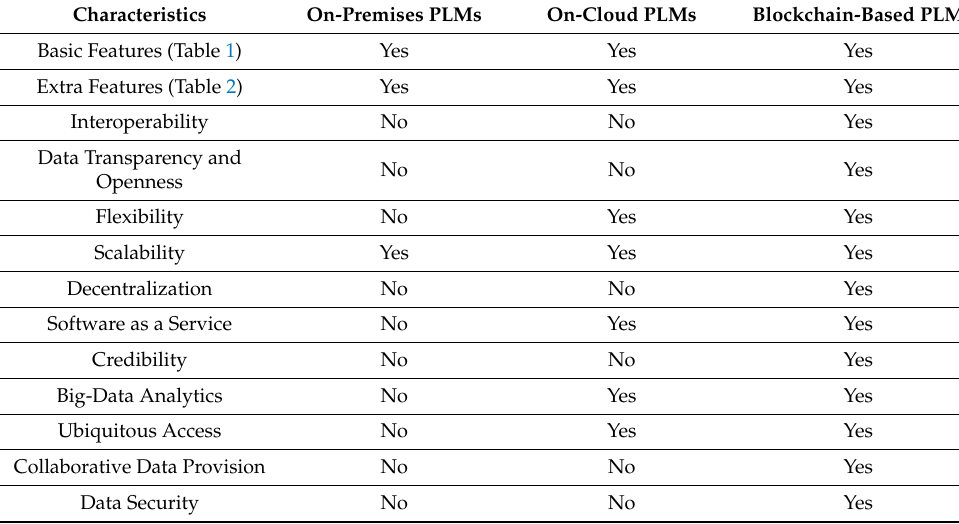
Figure 3. Data storage on the blockchain. Table 3. Comparison between Traditional and Blockchain-Based